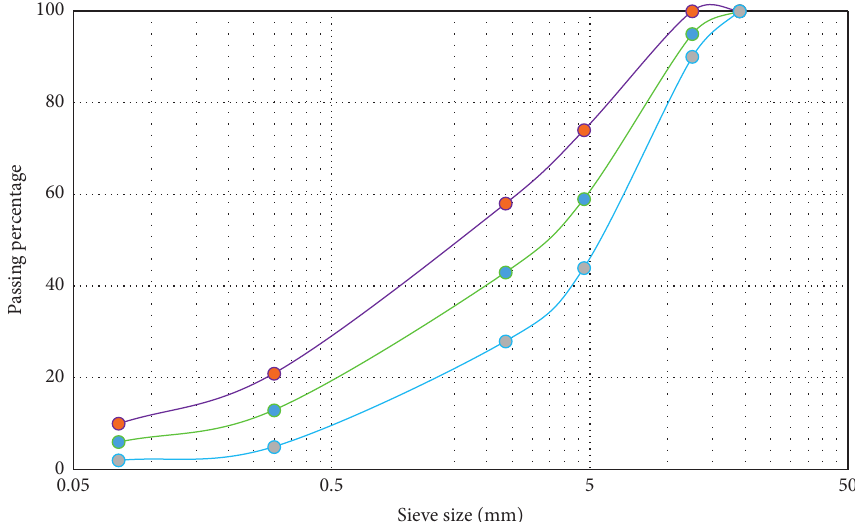
Figure 1: Applied grading of aggregate in the study.